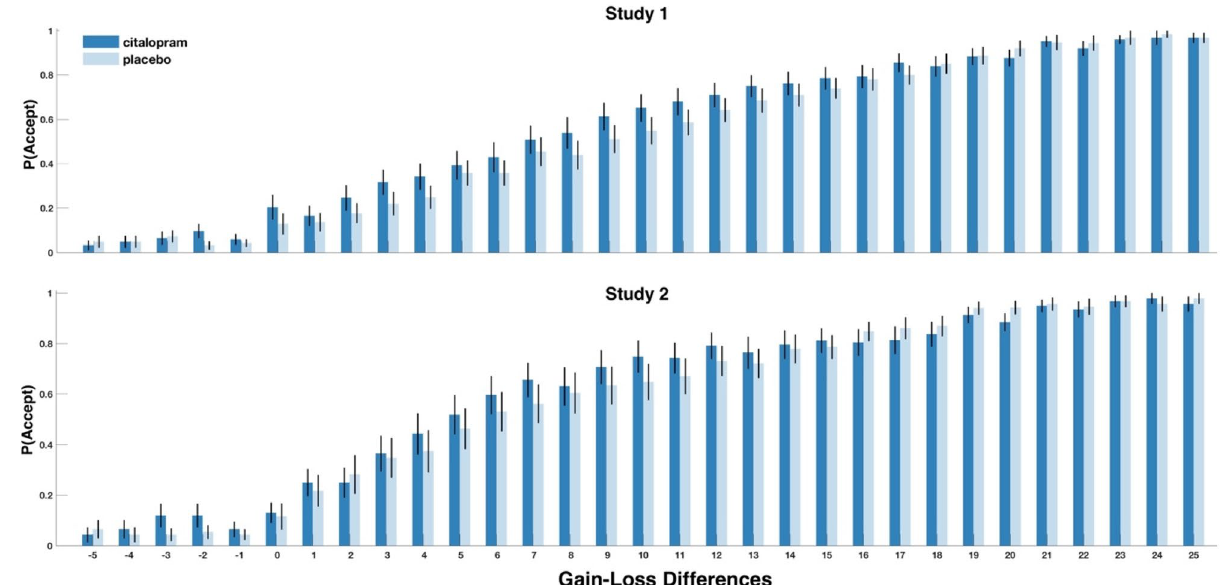
Figure 3. Greater acceptance of gambles of smaller outcome values under serotonin. Gambles with lower outcome value differences were on average more likely to be accepted after citalopram administration as compared to placebo. P(Accept) is the probability of accepting a gamble in Study 1 (above) and Study 2